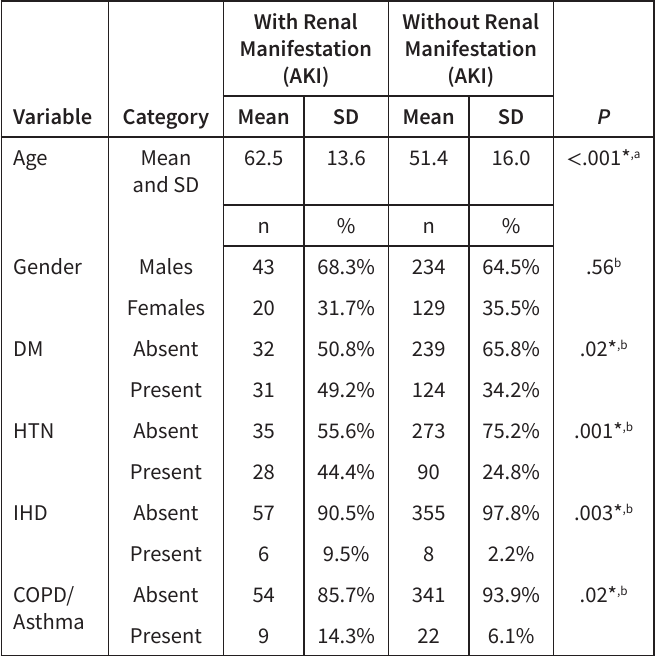
Table 1. Comparison of Demographic and Comorbid Conditions in COVID-19 Patients With and Without Renal Manifestation (AKI)